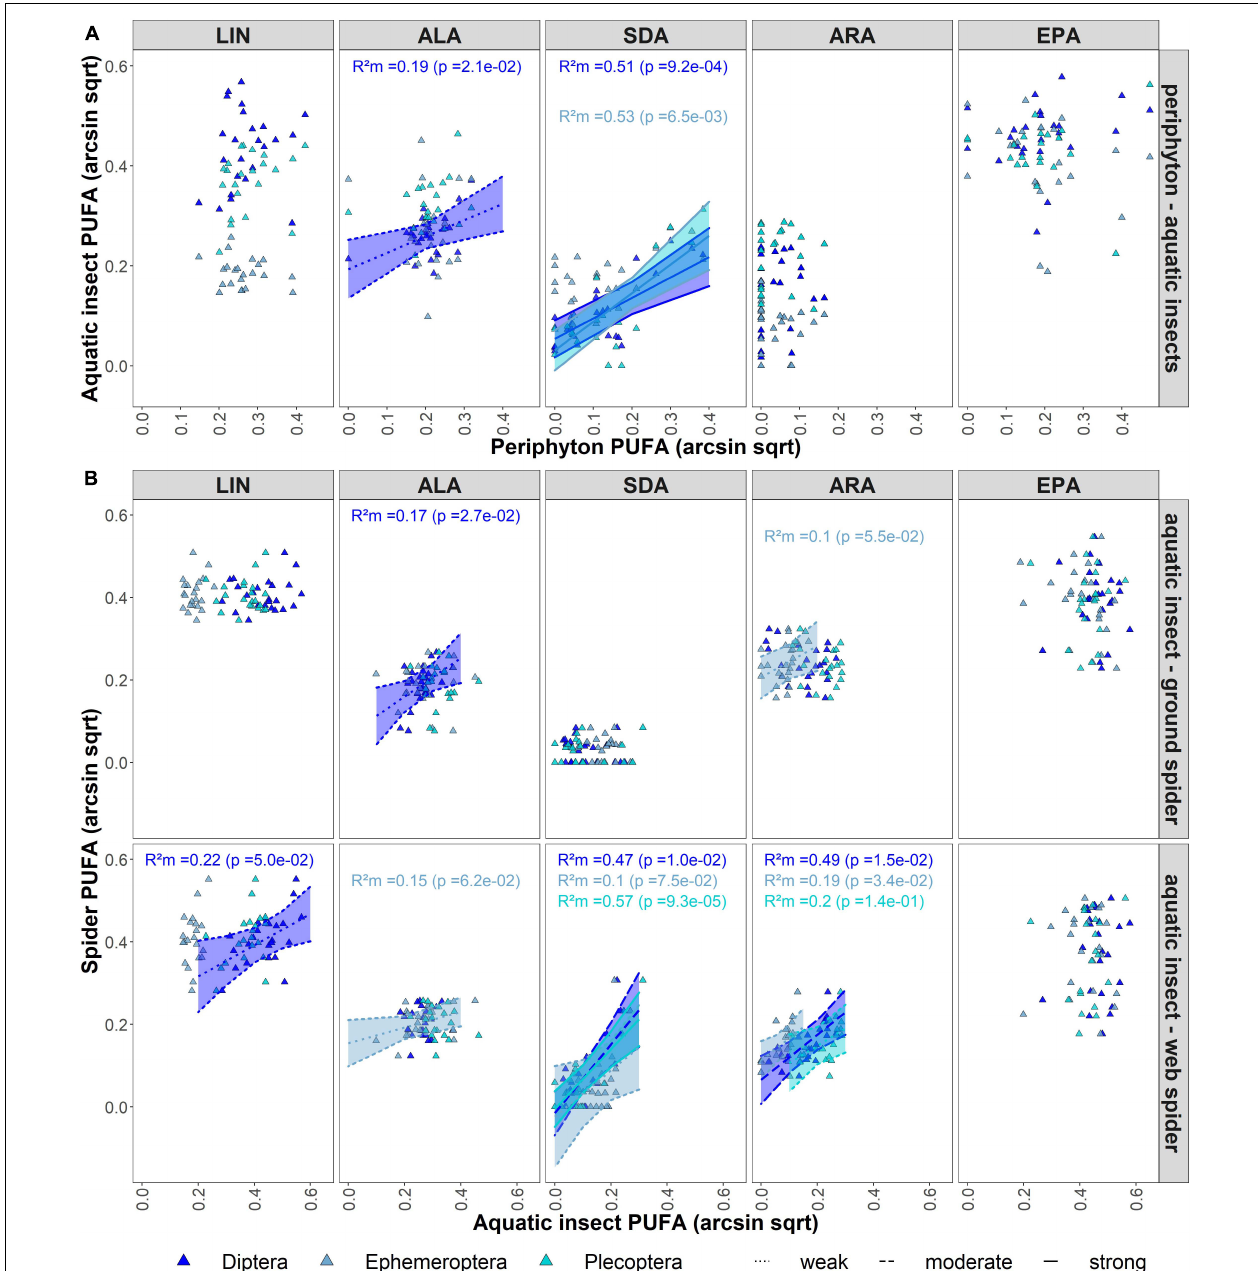
FIGURE 3 | (A) Mixed model showing effect of periphyton individual PUFA content on individual PUFA content of aquatic insects, with river and seasons as random effects. (B) Mixed model showing effect of aquatic insect individual PUFA content on individual PUFA content of riparian spiders, with river and seasons as random effects. If no trendline is shown, predictive effect of fixed effect is close to zero (R 2 m < 0.1), dotted lines represents weak effects (R 2 m < 0.3), dashed lines represent moderate effects (R 2 m < 0.5) and solid lines represent strong effect (R 2 m > 0.5).